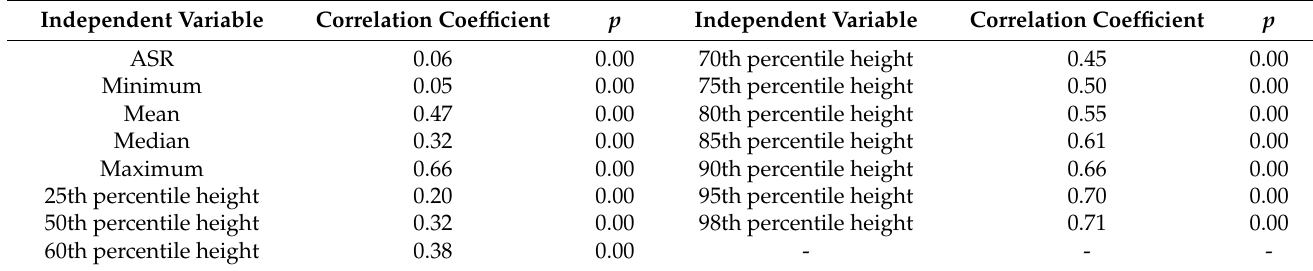
Table 5. The correlation coefficient between the ASR, height metrics, and measured forest canopy height.